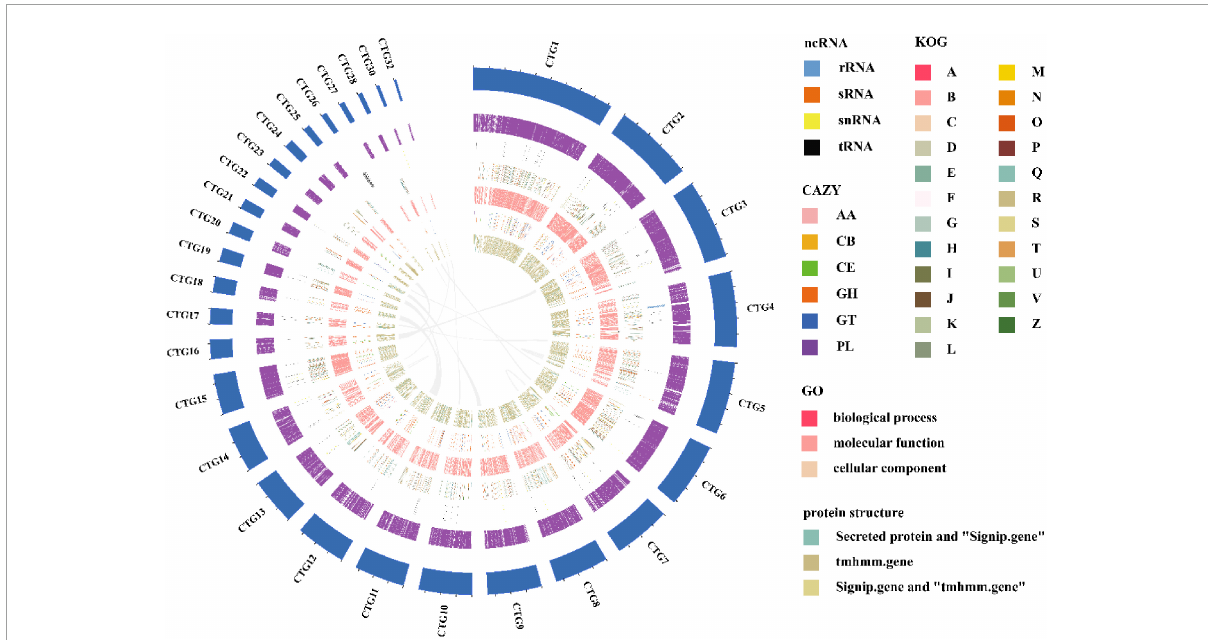
FIGURE2 A circular genome map of I. hispidus . From outside to the center: circle 1: contig keyboard; circle 2: gene density; circle 3: ncRNA; circles 4–6: the predicted protein-coding genes using KOG, GO, and CAZy databases, respectively, where different colors represent different function classifications; 7th circle: large fragment duplication.